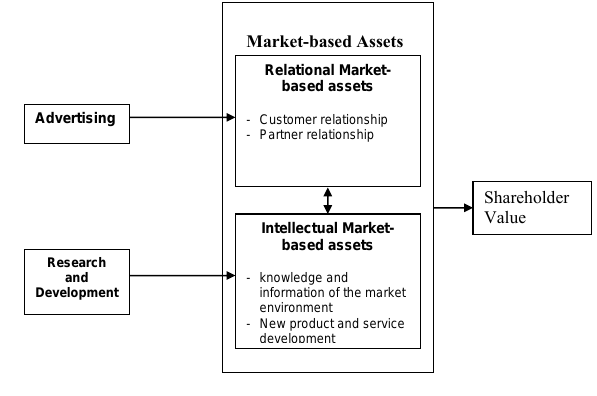
Figure 1: Conceptual